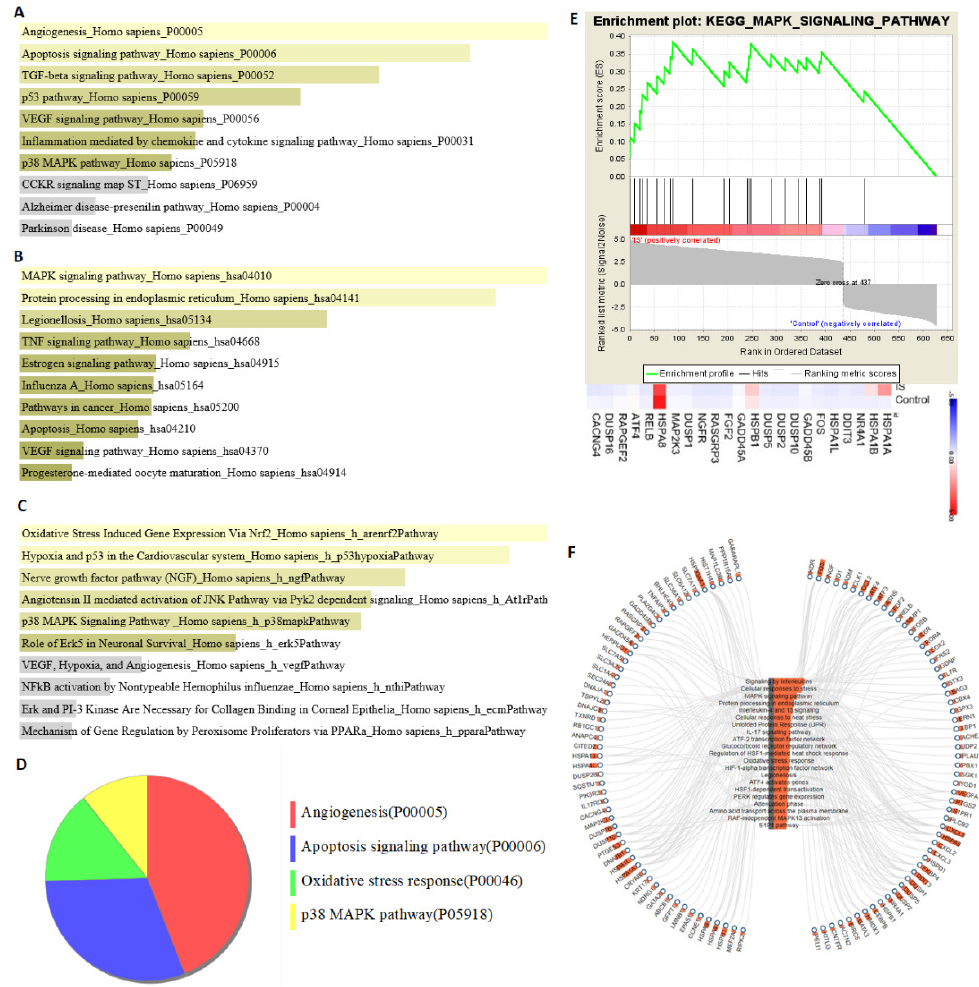
Figure 5. Pathway enrichment analysis of differentially expressed genes. The results of ( A ) PANTHER (Protein ANalysis THrough Evolutionary Relationships), ( B ) KEGG (Kyoto Encyclopedia of Genes and Genomes), and ( C ) BioCarta pathway enrichment analyses performed using Enrichr method. ( D ) The major PANTHER pathway identified using the Benjamini–Hochberg false discovery rate (FDR) multiple test correction. ( E ) The Gene Set Enrichment Analysis (GSEA) result of differentially expressed genes. The 628 differentially expressed genes in IS-treated astrocytes were uploaded into GSEA for enrichment analysis. The KEGG gene sets database was used as the gene set collection for analysis. GSEA performed 1000 permutations. The cutoff for significant gene sets was a false discovery rate <25%. ( F ) The correlation of KEGG pathway and associated gene expression on IS-treated astrocytes using WebGIVI web-based gene visualization tool. The bar chart on the node represents the frequency of the said